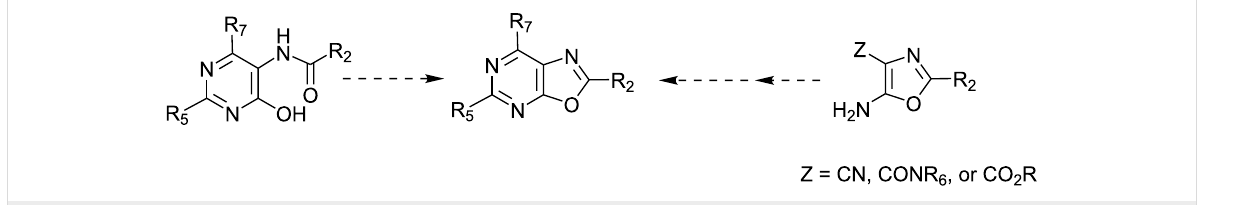
Figure 1: The two general synthetic approaches to oxazolo[5,4- d ]pyrimidines.